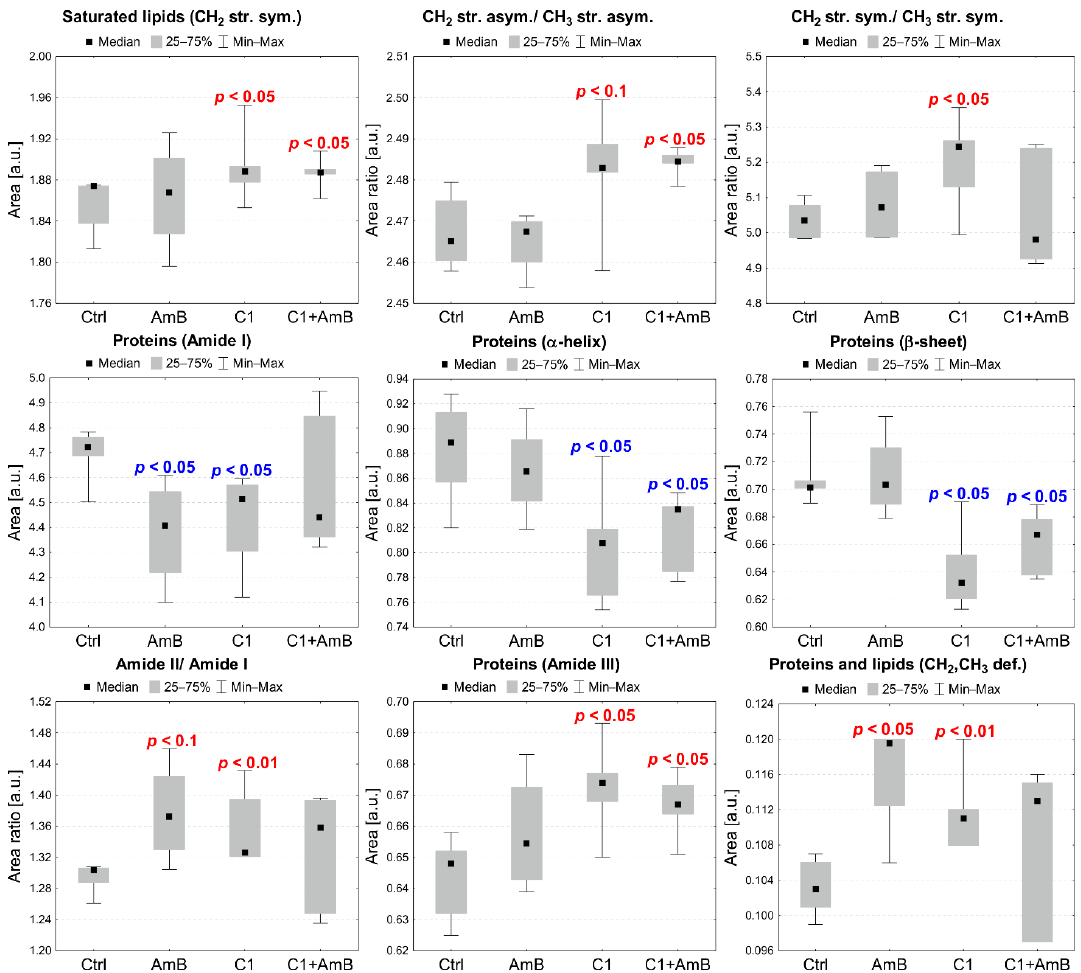
Figure 9. Median, minimal, and maximal values of the intensities of selected absorption bands, presenting differences between RPTEC subjected to the C1, AmB, and C1 + AmB treatment and the control (Ctrl) group. The p -values of the Mann – Whitney U test for statistically significant changes, compared to the control, are shown in the charts (red — increases, blue — decreases).